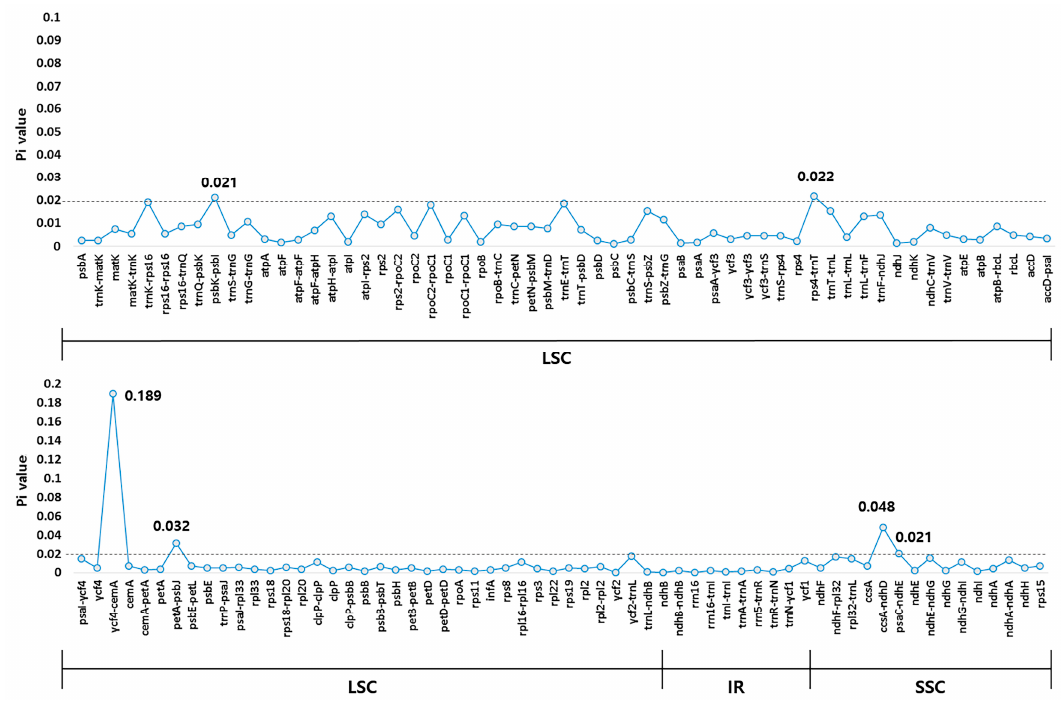
Figure 4. Comparison of nucleotide diversity ( Pi ) between the CP genomes of A. polymorpha and L. officinale .